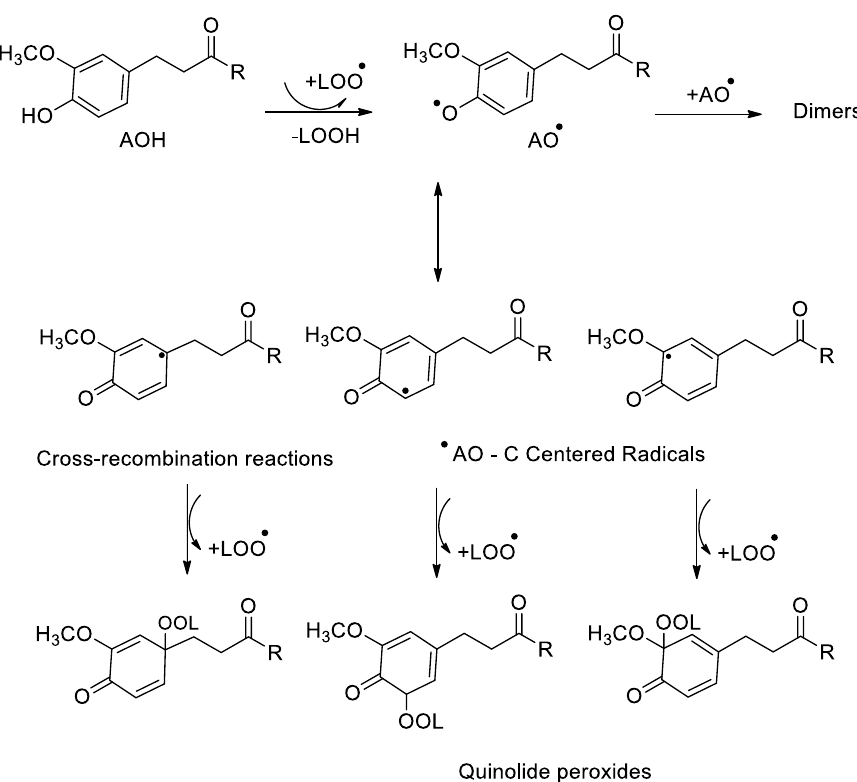
Scheme 3. Reaction mechanism for ortho -methoxyphenols (group A3) during lipid autoxidation: reactions with lipid peroxide radicals, reactions of homo-recombination of phenoxyl radical (AO • ), resonance structures of AO • (O- and C-centered radicals) and quinolide peroxide formation.